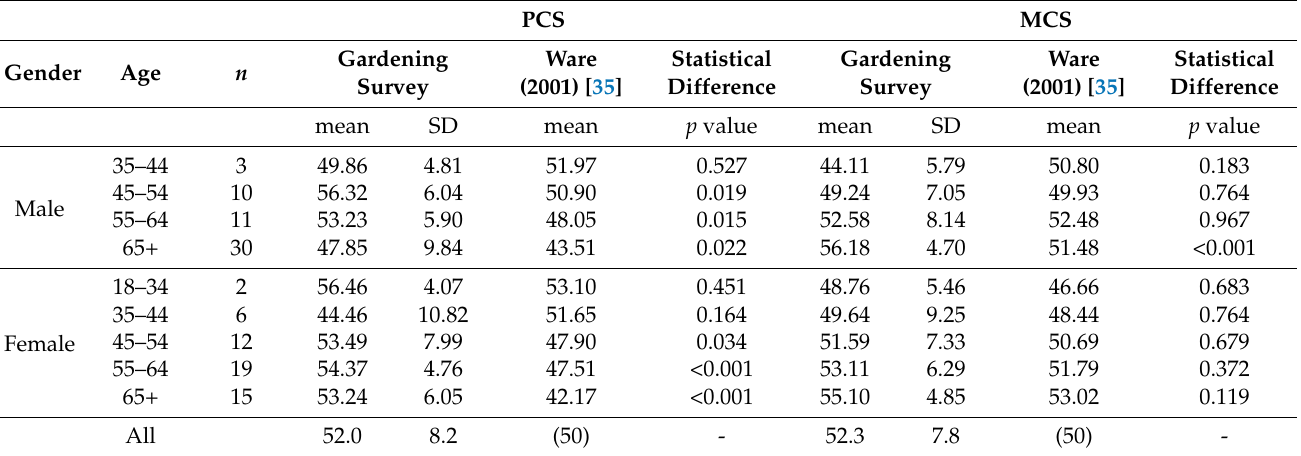
Table 2. Physical component summary (PCS) and mental component summary scores from the SF 36 v2. Means for individual age and gender categories were compared to means from Ware and Kolinski (2001) [35] using a t -test.